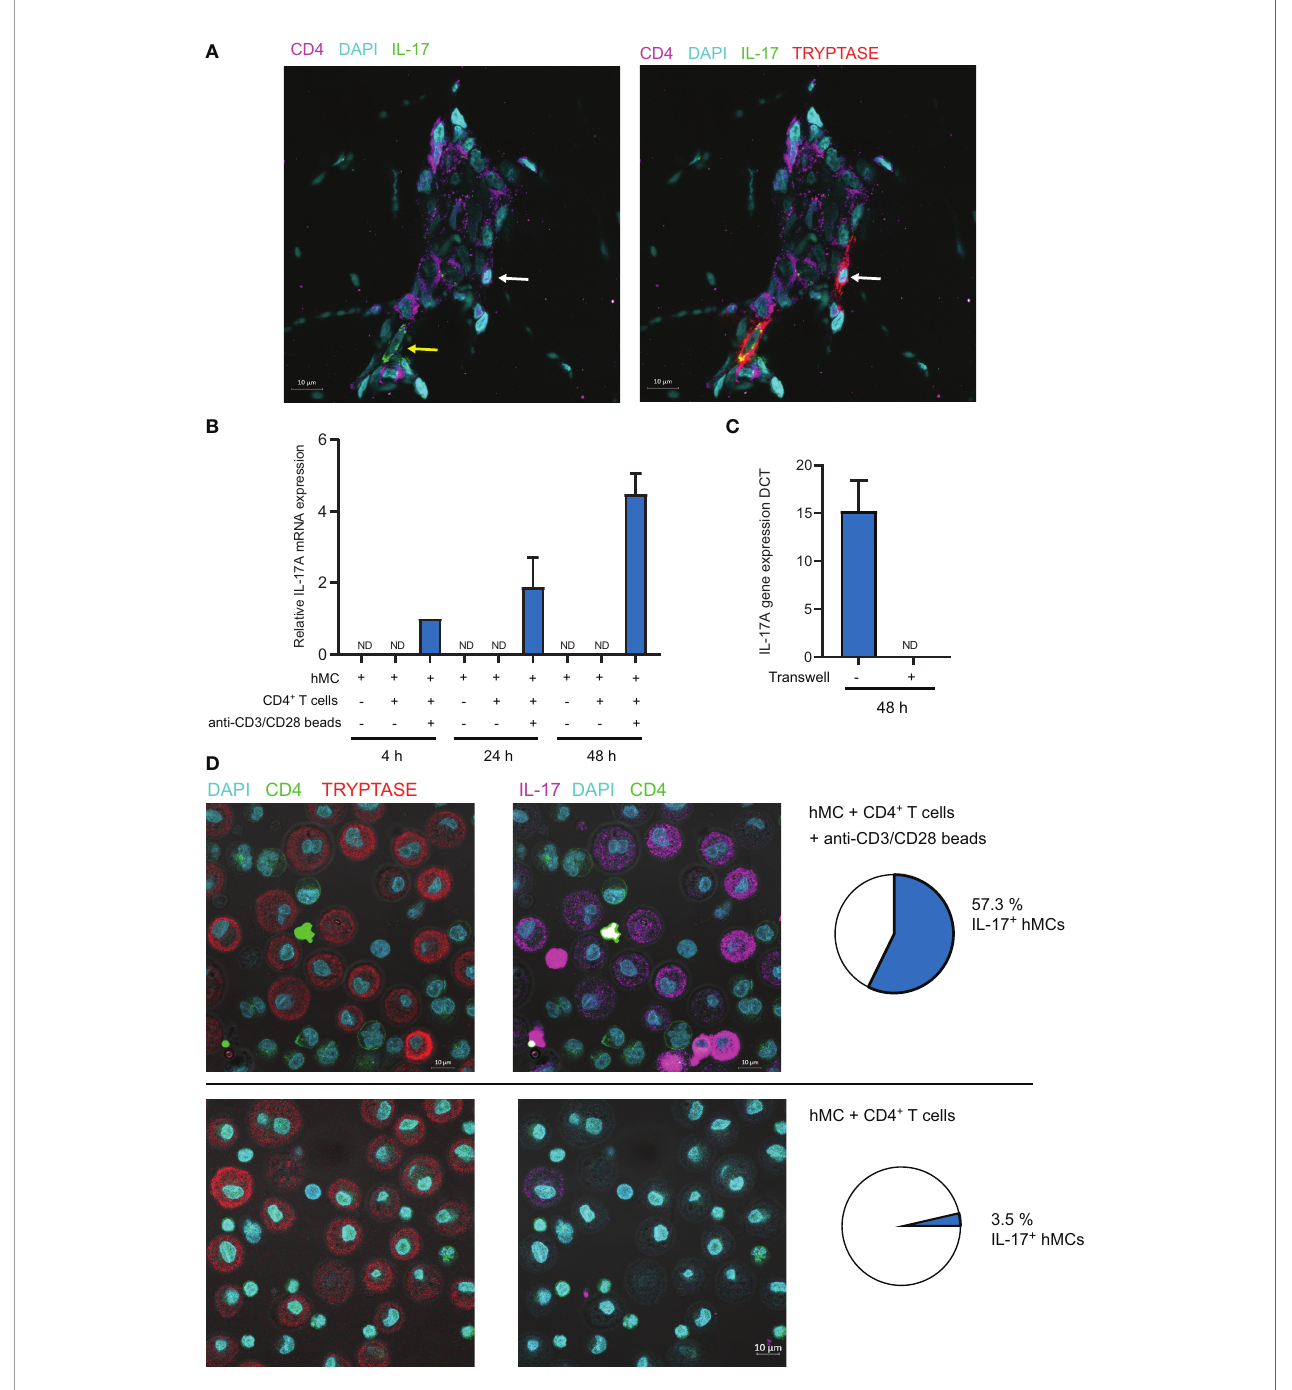
FIGURE 5 | Activated CD4 + memory T cells induce IL-17A mRNA expression in mast cells in a contact-dependent manner. (A) Typical example of tryptase+ mast cell in contact with CD4+ T cell in CC biopsy. Yellow arrow shows IL-17 + mast cell, White arrow shows IL-17 - mast cell. (B) hMCs and memory CD4 + T cells were cocultured (with or without anti-CD3/CD28 coated beads) for indicated time. hMCs were FACS sorted and IL-17A mRNA expression was quanti fi ed by RTqPCR. (C) hMCs and activated memory CD4 + T cells with anti-CD3/CD28 coated beads were cocultured for 48h with or without the possibility to establish contacts (separation by a 0.4µm membrane in Transwell coculture systems). hMCs were FACS sorted and IL-17A mRNA expression was quanti fi ed by RTqPCR. Mean +/- SD from 3 independent experiments (hMCs from 3 different donors). (D) IL-17 and tryptase intracellular stainings in hMCs and memory CD4 + T cells cocultured (with or without anti-CD3/CD28 coated beads) for 48h. Typical confocal images and quanti fi cation of IL-17 + hMCs (n>200) representative of 3 independent experiments (3 different hMC/CD4 + T cell pairs). ND, not